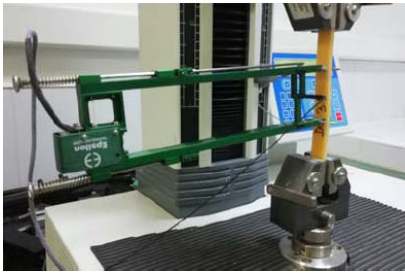
Figure 3. The tensile test assemblage of a sample from the hybrid resin.